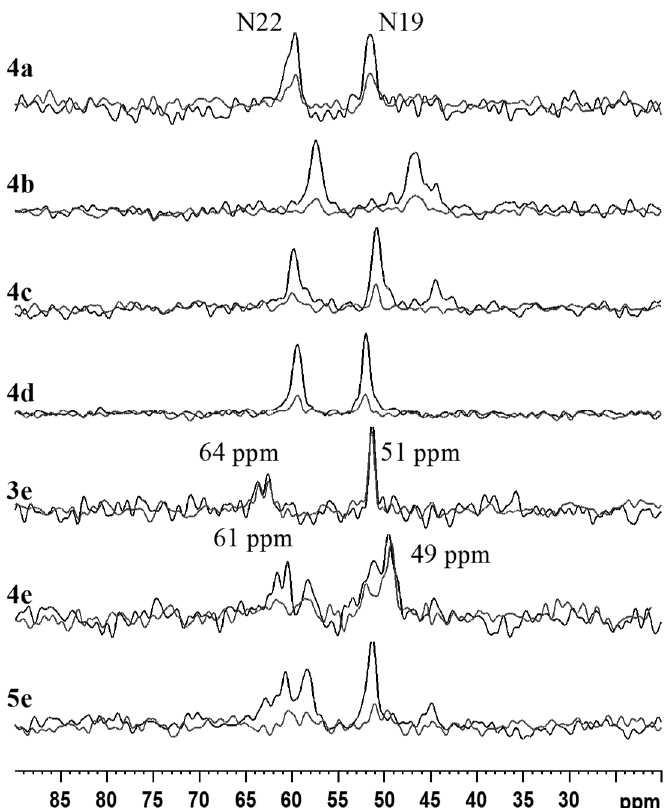
Figure 3. 15 N-CP/MAS NMR and 15 N-CPPI/MAS NMR (PI = 100 µs) spectra of compounds 4a (R = H), 4b (R = 2-F), 4c (R = 4-F), 4d (R = 2-OCH 3 ), 3e (R = 4-OCH 3 , base), 4e (R = 4-OCH 3 , eq. HCl) and 5e (R = 4-OCH 3 , excess of HCl) together with signal assignment.